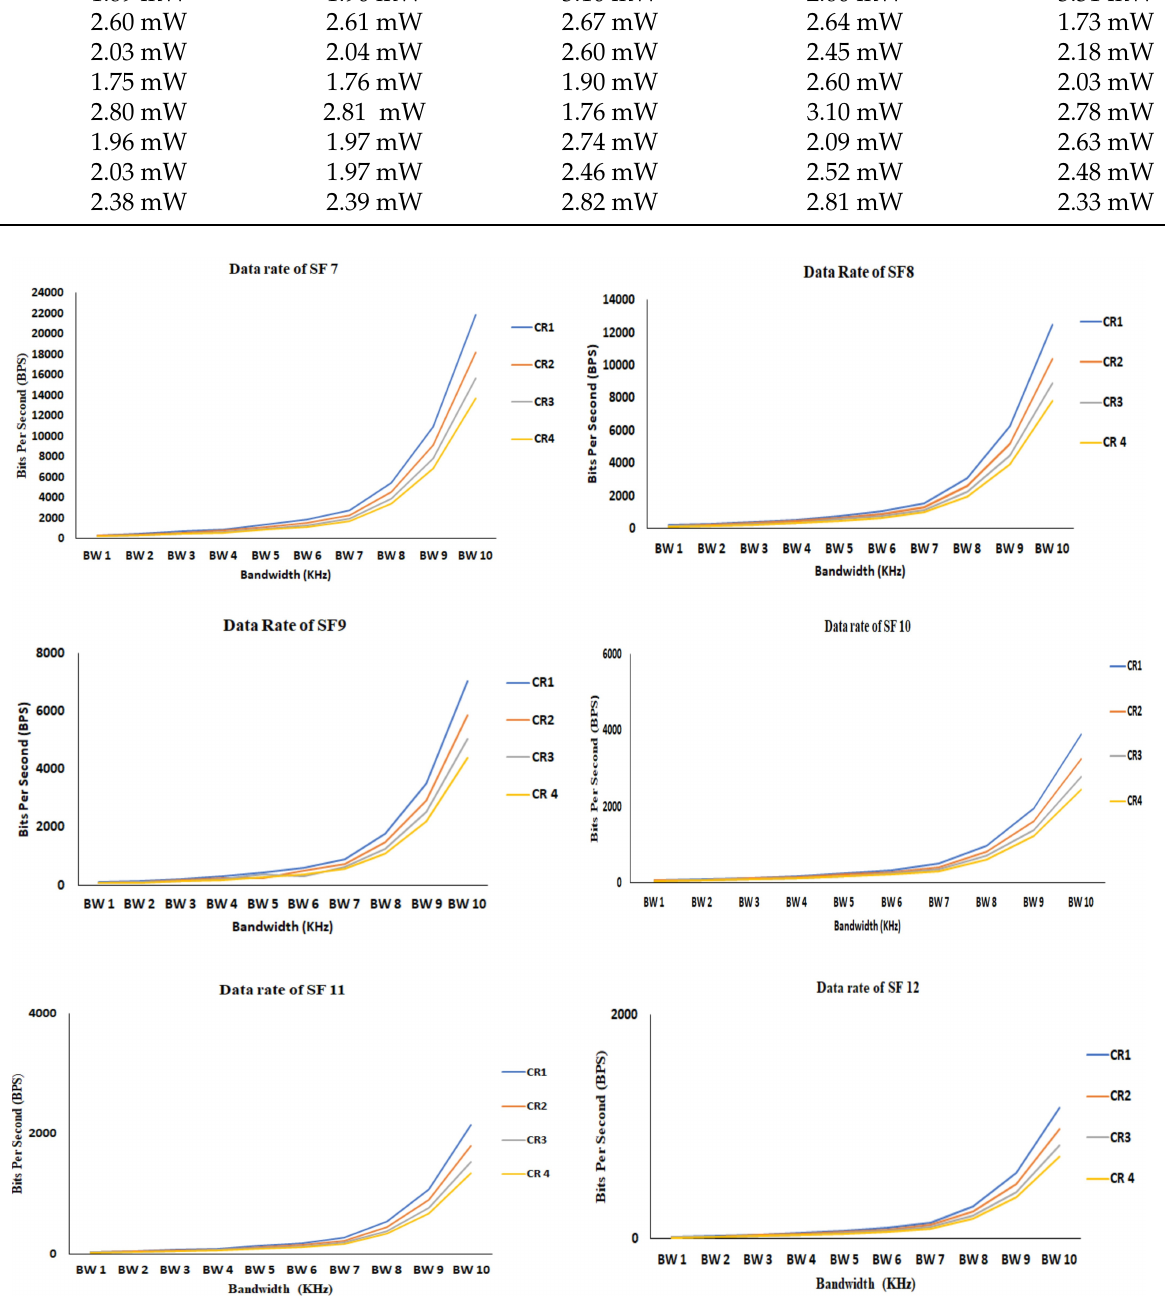
Figure 8. Data rate of LoRa from spreading factor (SF) 7 to SF